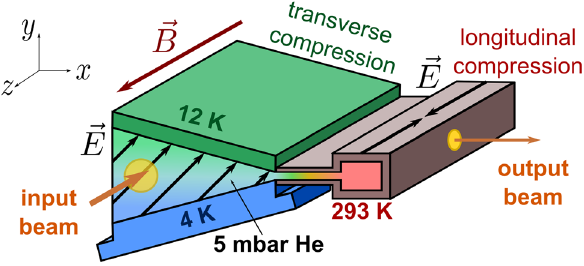
Fig. 1 Overview of the proposed phase space compression scheme. A standard surface muon beam, propagating along the − z -direction, is stopped in cryogenic helium gas with a vertical temperature gradient insidea5Tmagneticfield.Thestoppedmuonswarmisthencompressed by means of E - and B -fields in the y -direction (“transverse compres- sion”), and at the same time it is steered in the x -direction towards the longitudinal compression stage. There, the He gas is at room tempera- ture,andthereisacomponentoftheelectricfieldparalleltothemagnetic field axis. Thus, the muon swarm is compressed towards the center of this stage. Finally, the muons with a swarm size of O (mm) are extracted through a small orifice into vacuum, where they are re-accelerated and sent to the next